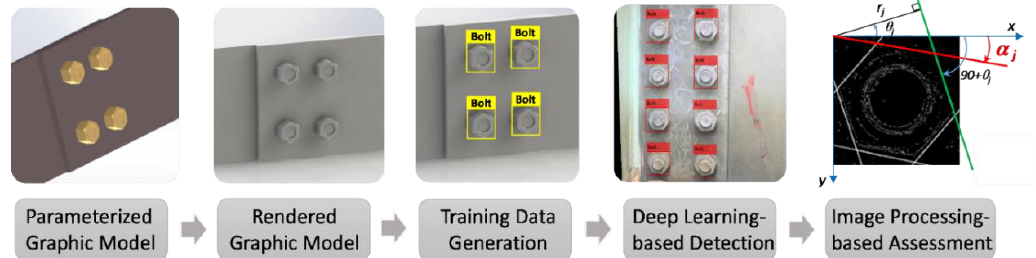
Figure 1. Figure 1. Framework for bolt-loosening monitoring through image-based deep learning and a graphical model.